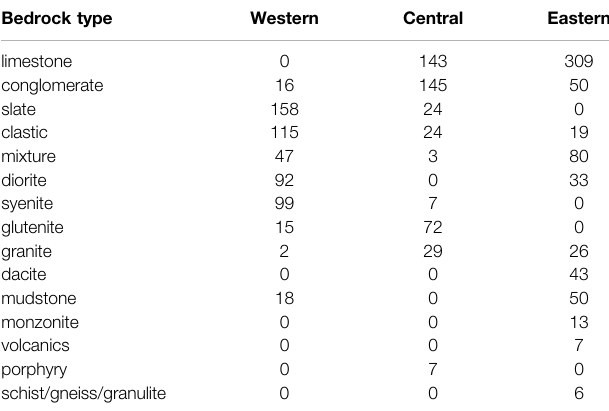
TABLE 5 | Statistics of cirque bedrock types in the western, central, and eastern parts of the Gangdise